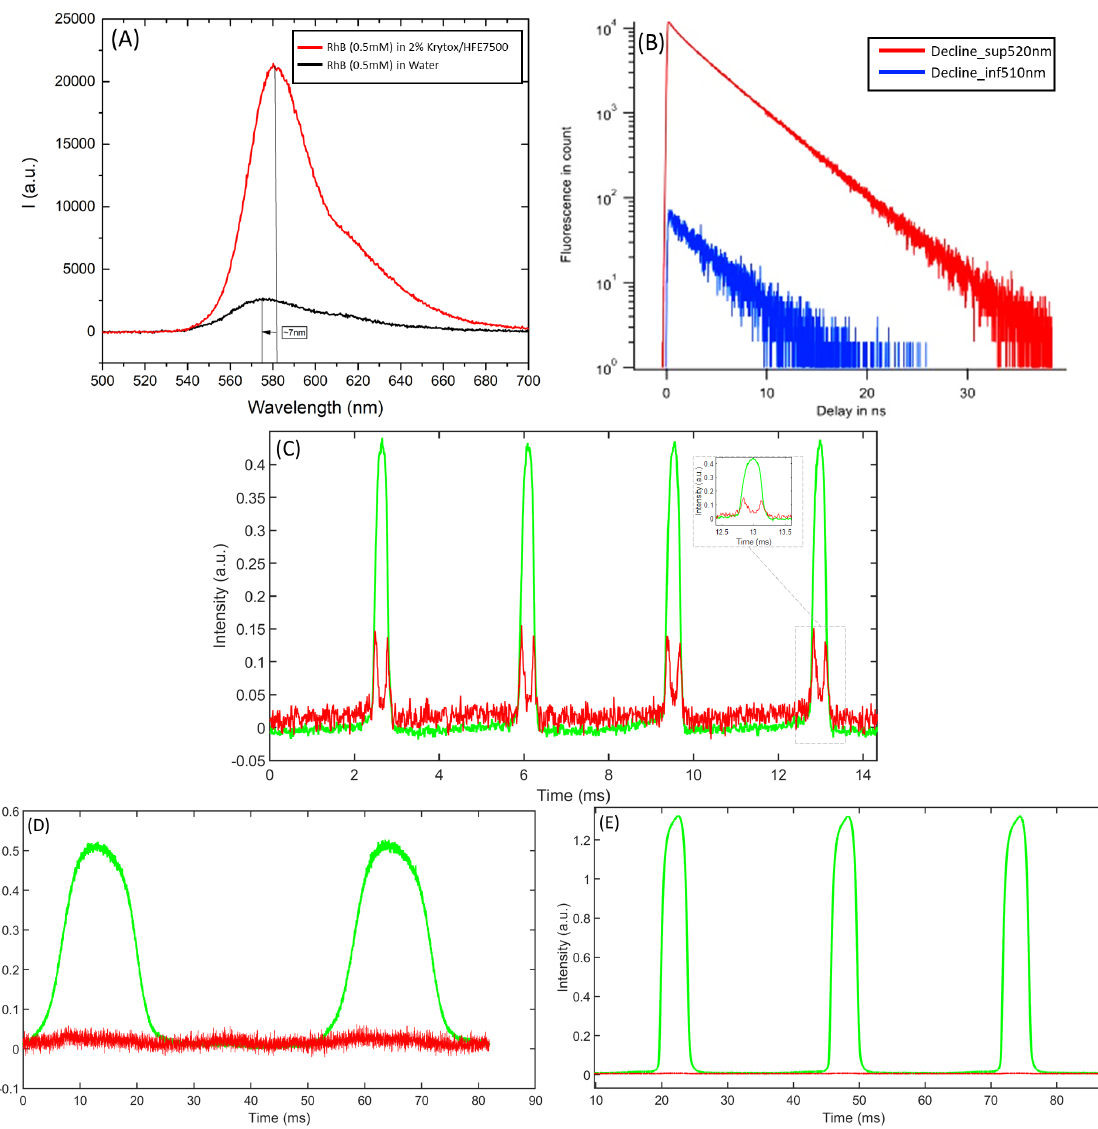
Figure 2. Rhodamine-B emission into different solvents and in different experimental conditions used in the experiment. ( A ) Fluorescence spectrum of RhB (Rhodamine-B) dissolved in water (Red) and in fluorocarbon oil with 2% wt. krytox surfactant (Black); ( B ) fluorescence lifetime graph of the RhB dissolved in krytox/fluorocarbon oil; ( C ) Fluorescence intensity vs. time plots of RhB in water droplets flowing in HFE-7500 fluorocarbon oil (containing krytox surfactant (2% wt.), each pulse represents the passage of a single droplet across the 532 nm excitation laser beam, and each droplet passage shows two distinct signals, one in green, which corresponds to standard fluorescence signal above 540 nm, but the red color curve recorded in the 500–520 nm range (below the excitation wavelength) is what makes the sensitivity of our system a new detection scheme; ( D ) fluorescence intensity vs. time plots of large RhB in water droplets flowing in HFE-7500 fluorocarbon oil without any surfactant; ( E ) fluorescence intensity of RhB in benzyl alcohol droplets vs. time in HFE-7500 fluorocarbon oil; ( D , E ) are used as control experiments where no blue-shifted emission signal is